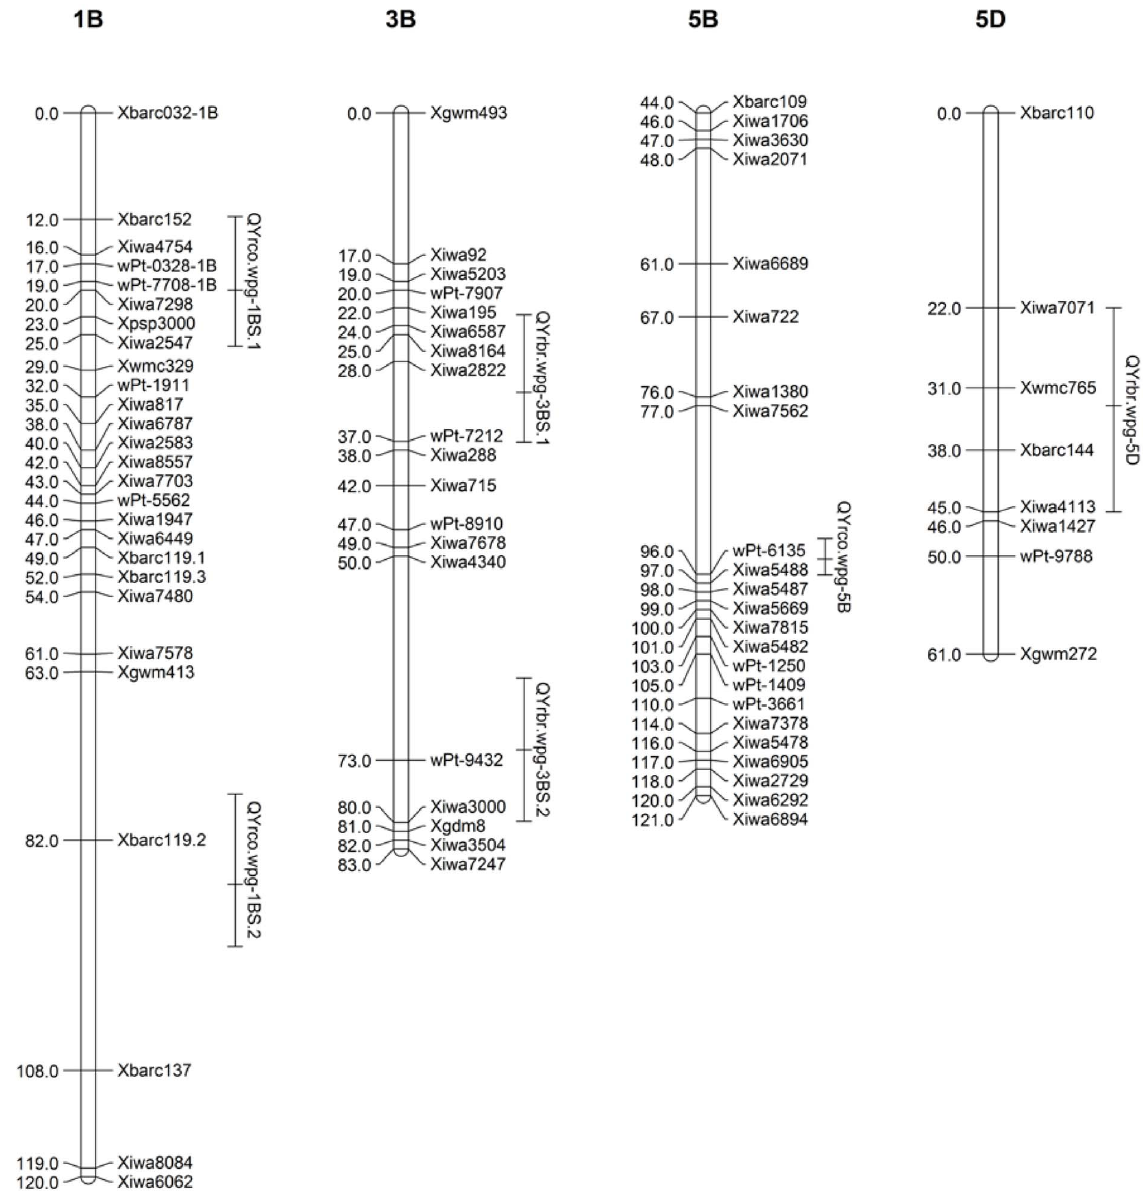
Figure 2. Selected portions of the genetic linkage map from the Brundage by Coda RIL population. Selected portions of the genetic linkage map from the Brundage by Coda recombinant inbred line population showing quantitative trait loci (QTL) containing portions of chromosomes 1B, 3B, 5B and 5D. Solid bars to the right of linkage maps outline QTL positions for infection type values and disease severity values, with a dash marking the position of the peak LOD score. Locations include: Central Ferry, WA; Mount Vernon, WA; Spillman Farm Pullman, WA; Whitlow Farm Pullman, WA; Parker Farm Moscow, ID; growth chamber seedling tests with races: PST-100, PST-114 and PST-127. Dates include 2006, 2010, and